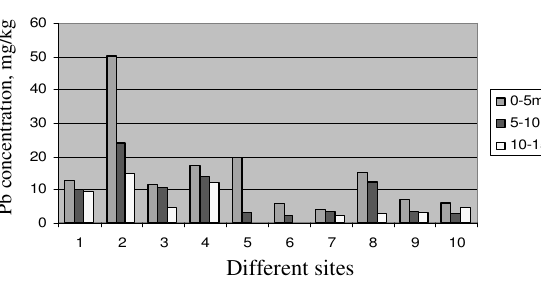
Figure 1. Pb (mg/kg) in roadside agricultural